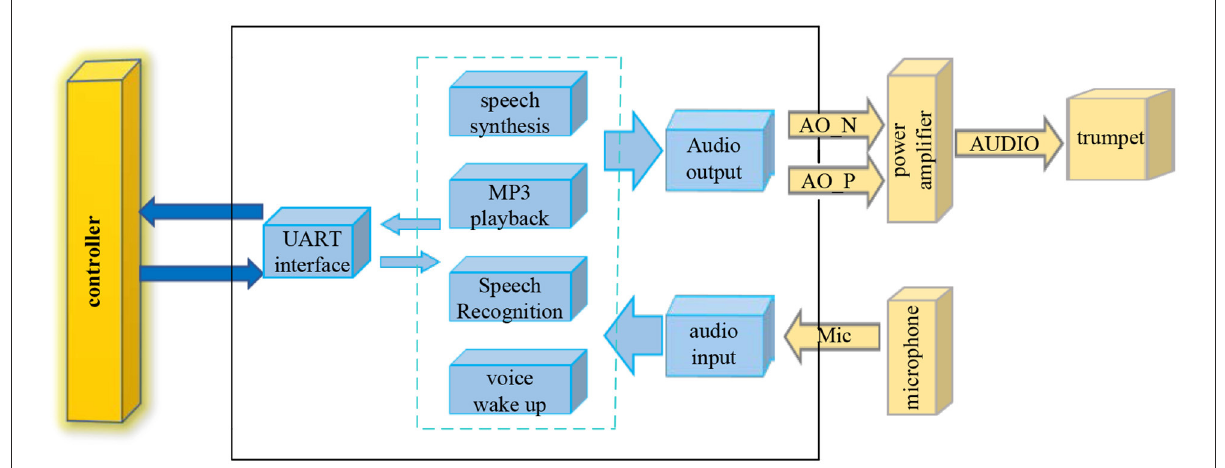
FIGURE1 Speech recognition structure diagram.